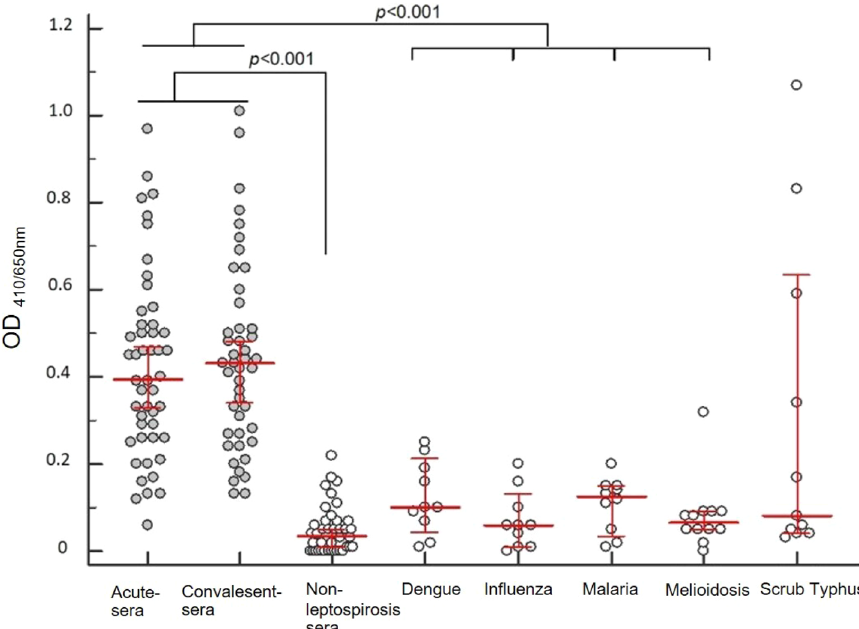
Figure 1. IgM reactivity of confirmed leptospirosis paired sera and controls assessed by rGroEL 1-524 IgM- ELISA. The IgM reactivity of acute and convalescent leptospirosis sera (closed circle), non-endemic healthy and AUFI control plasma (open circle), and other febrile illness control samples (open circle), comprising dengue fever, influenza, malaria, melioidosis and scrub typhus subgroups, were assessed rGroEL 1-524 IgM-ELISA assay. Individual IgM reactivity is expressed as AOD ELISA. The median AOD ELISA value and standard deviation (SD) of each subgroup are indicated. P < 0.001 is considered significantly